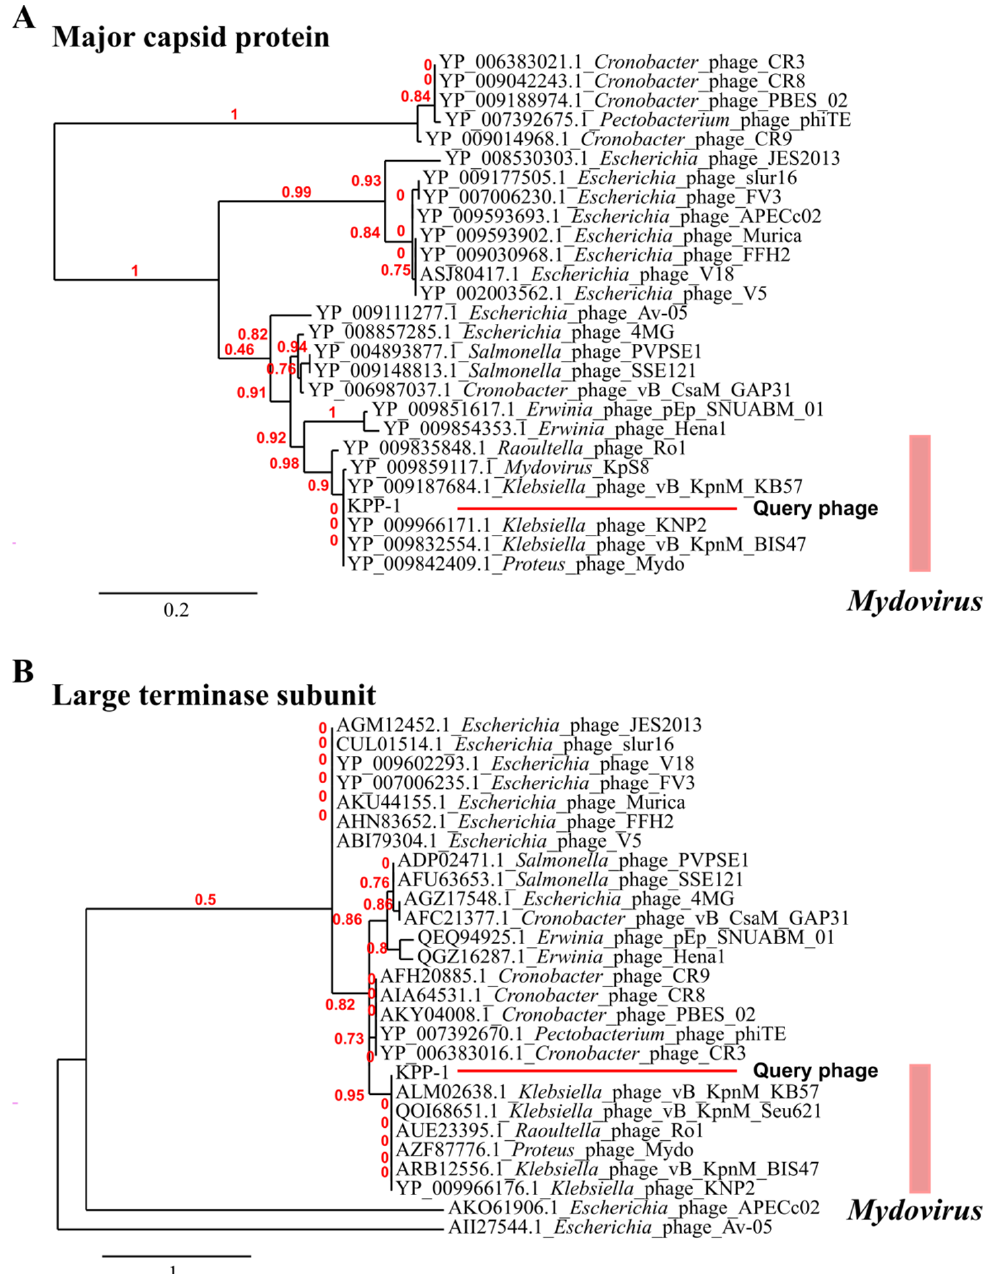
Figure 5. KPP-1 phylogenetic tree constructed using major capsid protein and the large terminase subunit. ( A ) phylogenetic tree based on major capsid protein. ( B ) phylogenetic tree based on large terminase subunit protein. Phylogenetic trees were constructed using maximum likelihood method for relevant sequences collected from bacteriophages belong to sub family Vequintavirinae . KPP-1 was grouped among the members of the genus Mydovirus